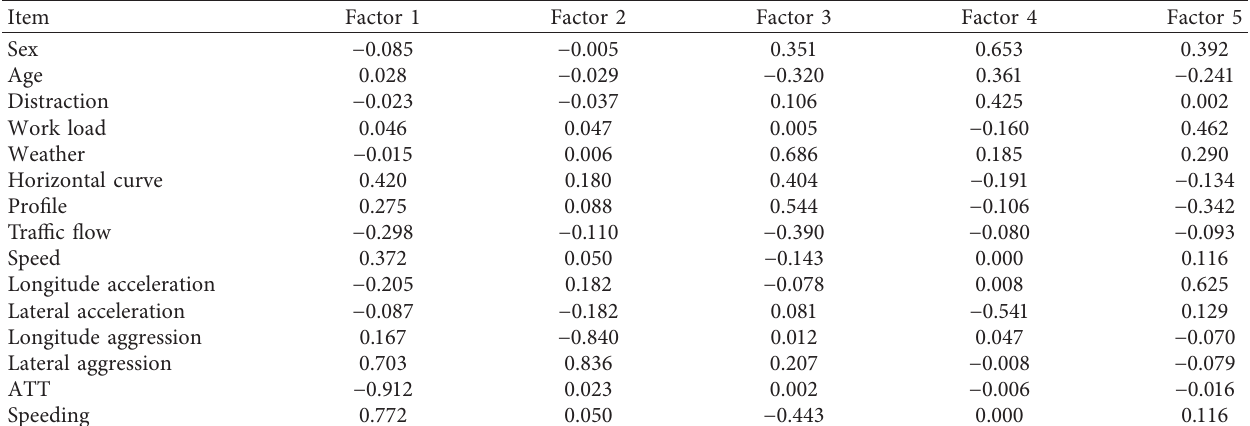
Table 5: Item factor loads.